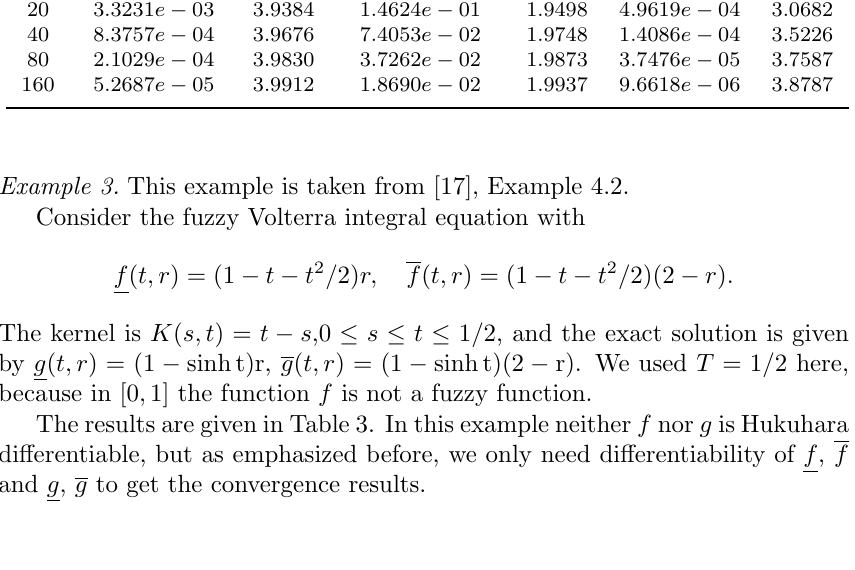
Table 3. Comparison of numerical results for Example 3. N error (triang.) ratio error (rectang.)